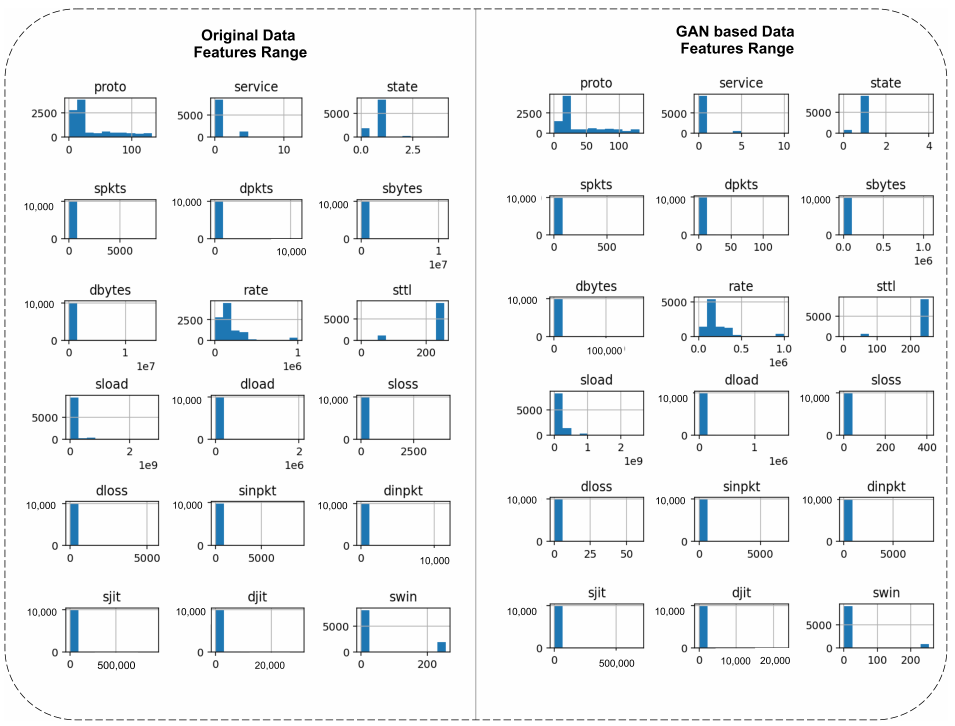
Figure 2. Features histograms for 18 columns in original dataset ( Left ) and GAN-based dataset ( Right